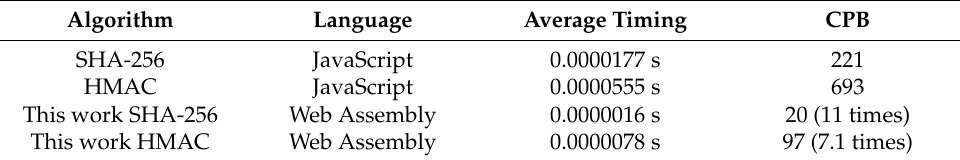
Table 18. HMAC algorithm performance in Microsoft Edge ( CPB : Cycle Per